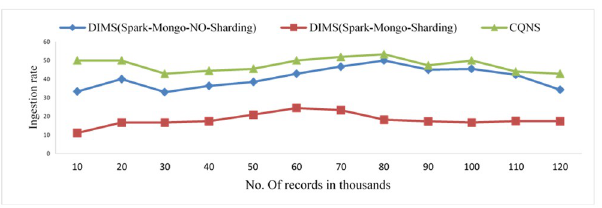
Fig 15. Comparison of the ingestion rate using dims mongo import, dims apache spark and CQNS.